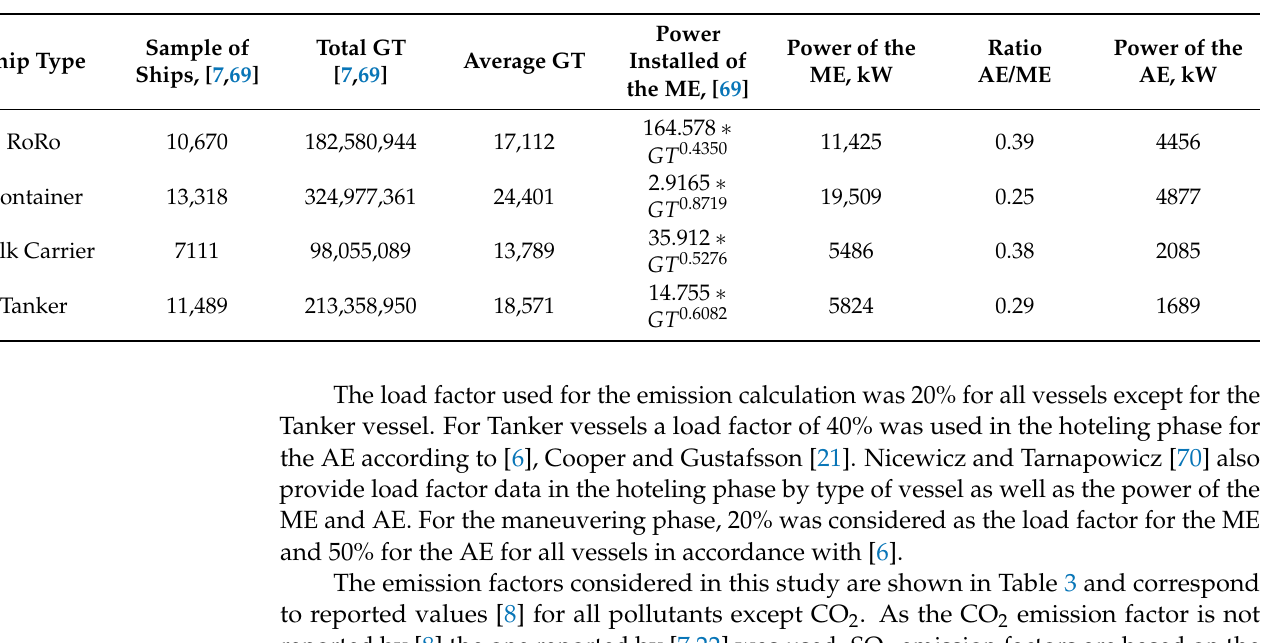
Table 2. Technical data for each type of vessel considered in this study. Data available for Sample of Ships, Total GT, and Power Installed of ME were adapted from [7,69].